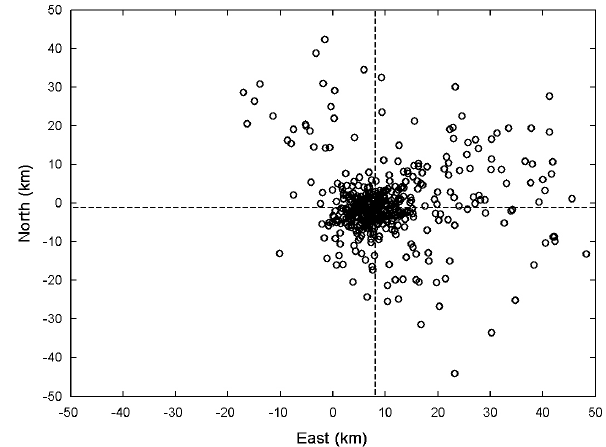
Fig. 7. The east-west and north-south distance differences between the 426 matched lightning event locations (WWLL-Kattron). The dotted lines indicate the median values of these